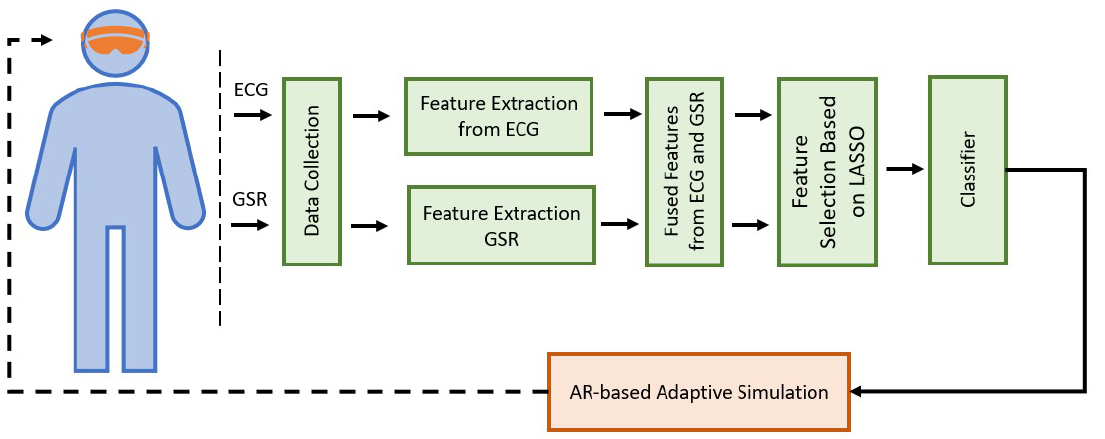
Figure 1. Proposed system